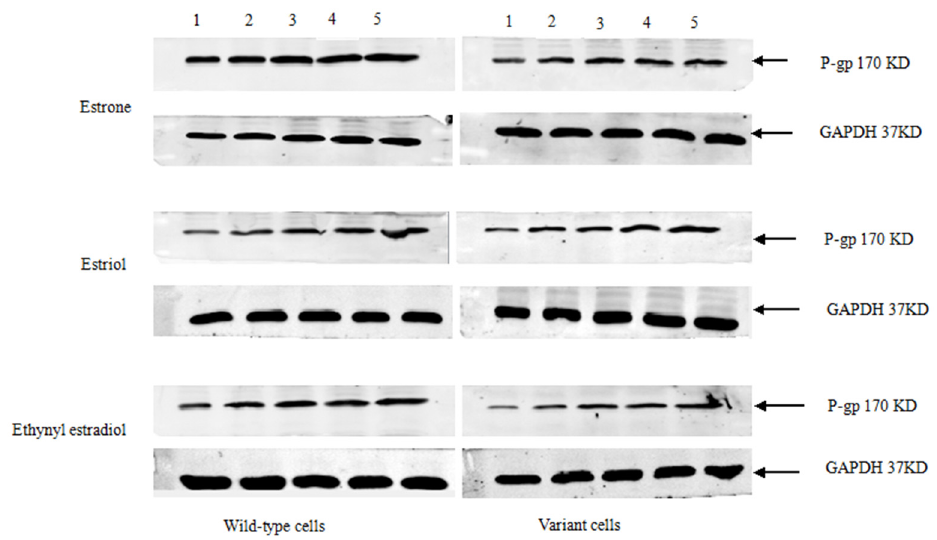
Figure 2. Western blotting of P-gp in LLC-PK1 cells expressing the ABCB1 (1199G) or